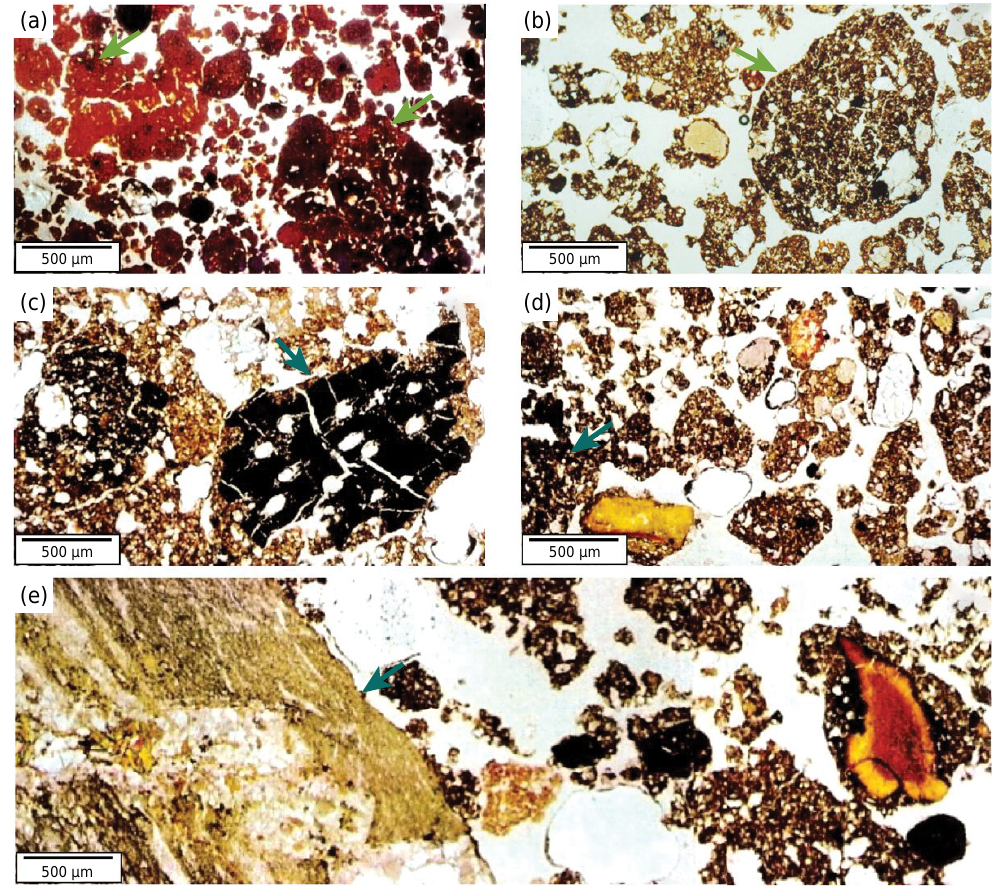
Figure 2. Photomicrographs of the Bw 2 horizon (a) in the P 1 - Acric Rhodic Ferritic Ferralsol (Clayic, Dystric) and of the Bi horizon (b, c, d, and e) in the P 2 - Eutric Chromic Leptic Cambisol (Humic, Loamic); Serra do Salitre topolithosequence. Arrows indicate pelletized materials filling and charcoal microfragments (a), well-developed microgranular structure in the cambic horizon (b), charcoal fragment (c), humified organic remains (d), and fragments from acid metapelitic rocks mixed with altered and pedoplasmated material of volcanic origin